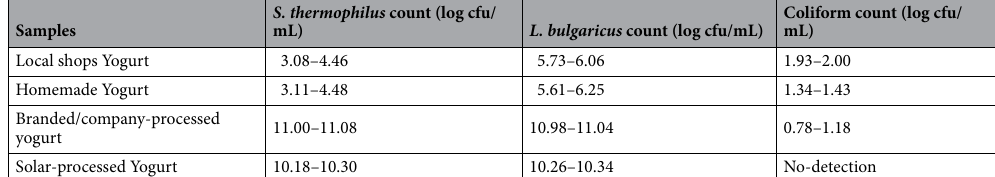
Coliform count (log cfu/ mL)